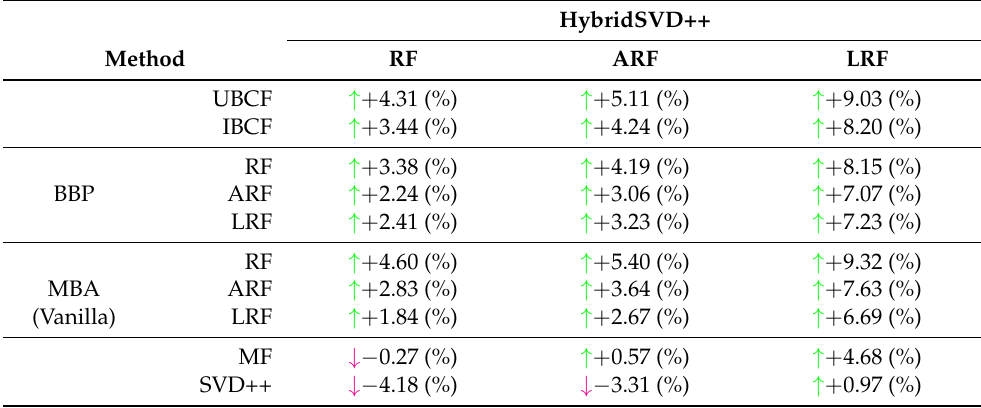
Table A2. HybridSVD++ with three weight types, RF, ARF and LRF were compared with other methods, and HybridSVD++(LRF) showed best reduction in RMSE. ( ↑ better , ↓